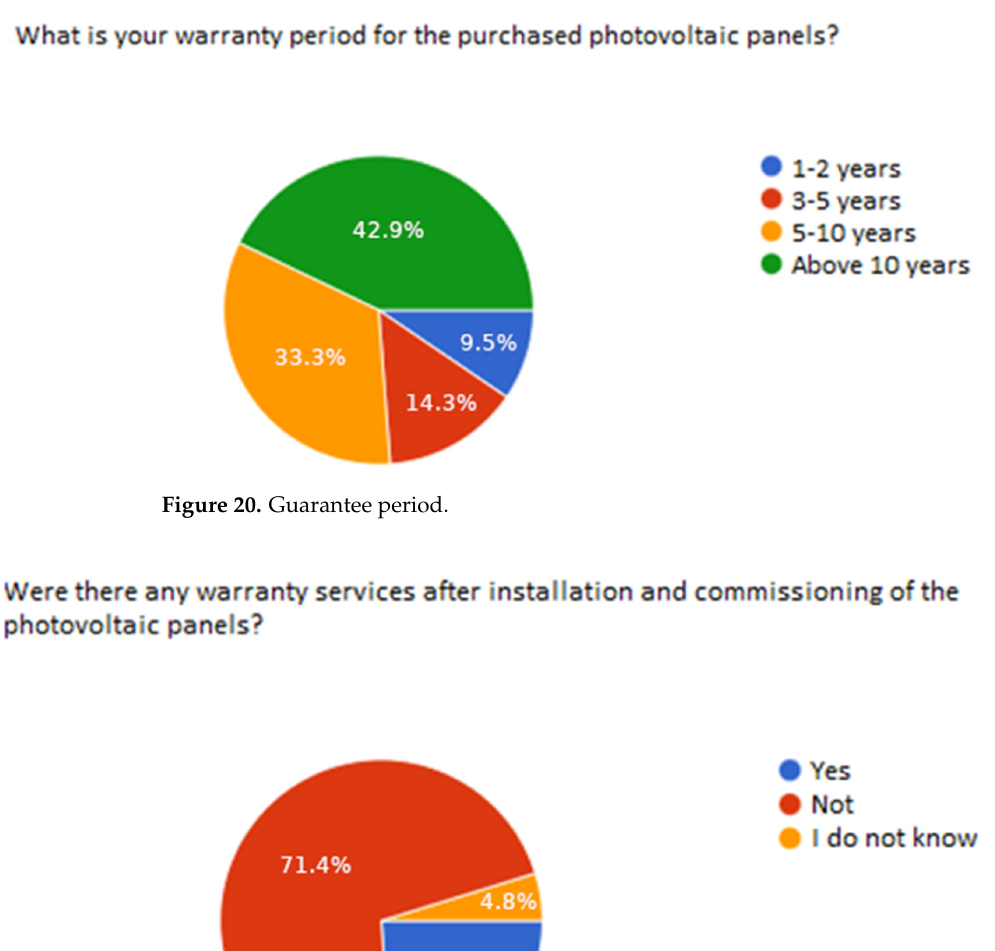
Energies 2022 , 15 , x FOR PEER REVIEW Figure 19. Contact with the service provider’s employees. Figure 19. Contact with the service provider’s employees.